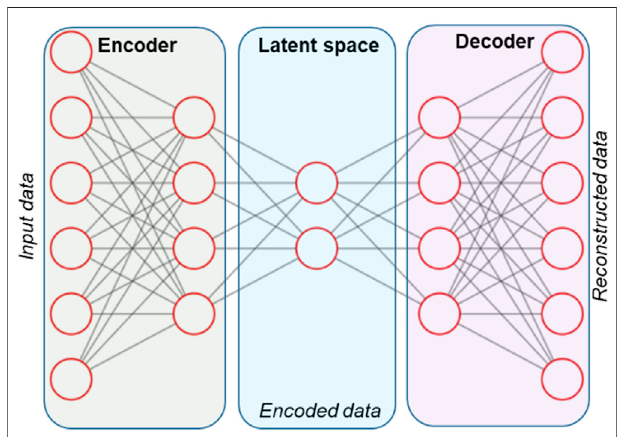
FIGURE 4 | Architecture of a typical autoencoder